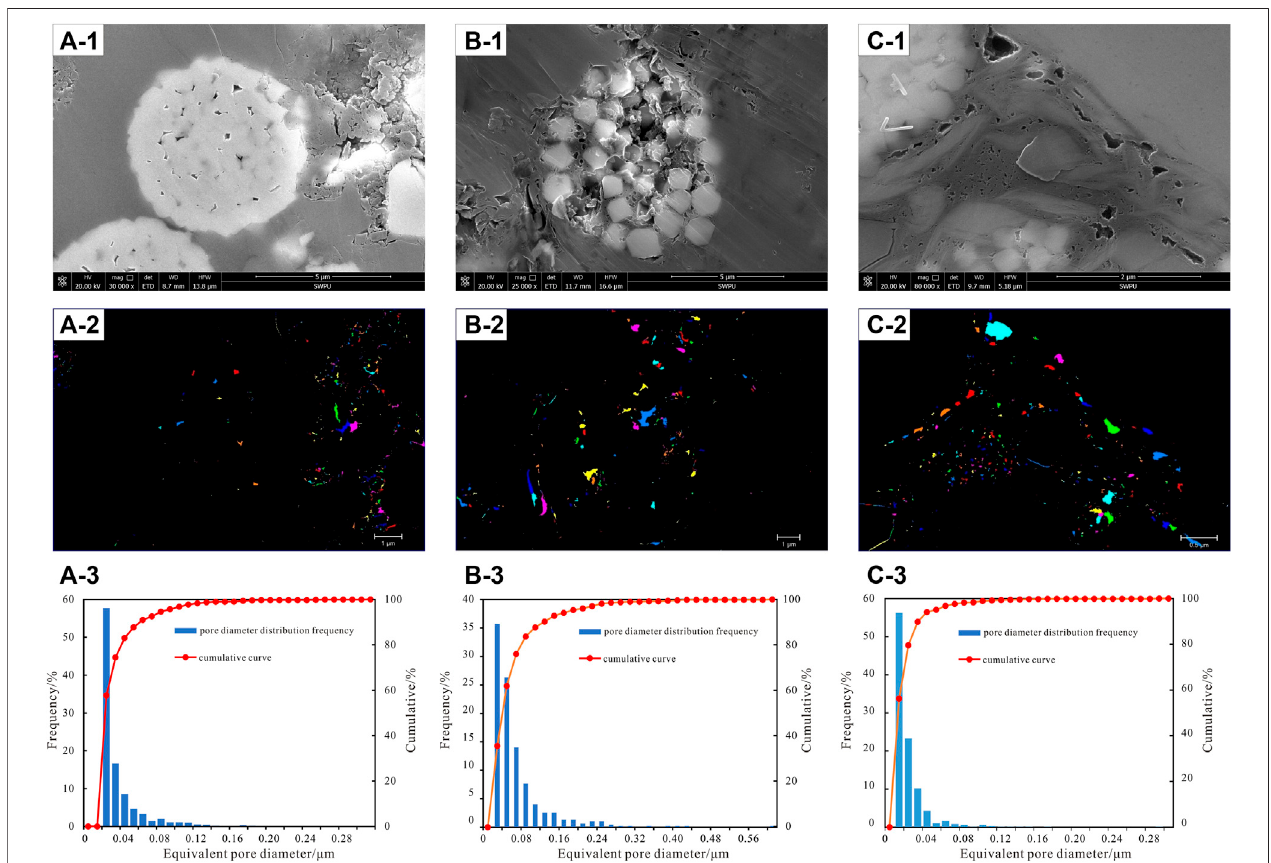
FIGURE 10 | Comparison of the pore structure characteristics of shale related to pyrite, (a-1, b-1, c-1 microscopic characteristics of shale, a-2, b-2, c-1 pore extraction characteristics, and a-3, b-3, c-3 equivalent pore diameter distribution), (A) 2326.45 m, well N2; (B) 2405.25 m, well N3; (C) 2215.36 m, well N4.